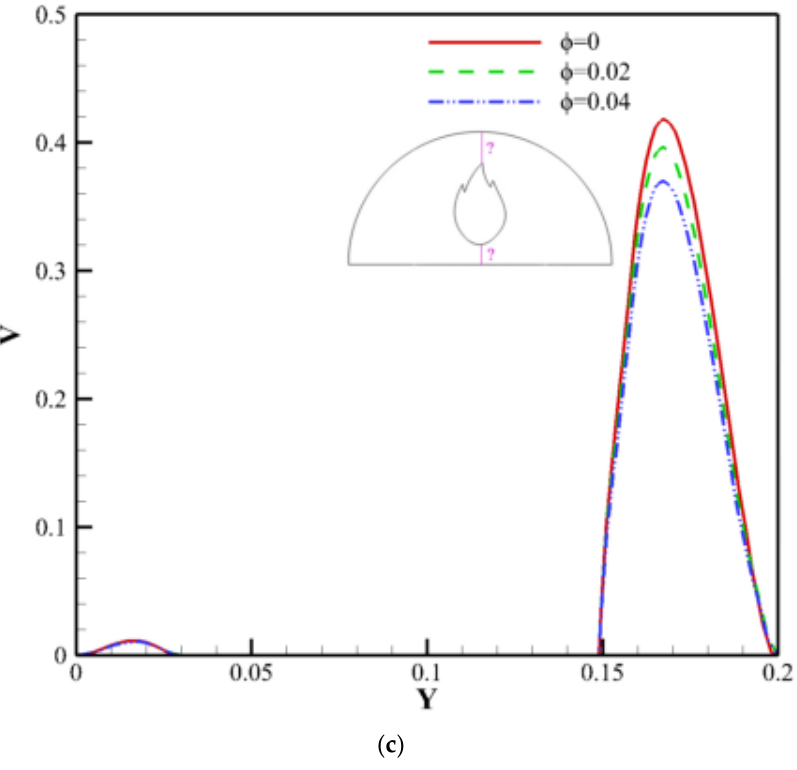
Figure 10. Variation of ( a ) Nusselt number at the enclosure heated length, ( b ) temperature along vertically mean position and ( c ) velocity alongside mean vertical location for different values of φ at (Rd = 0.5, Ha = 50, L = 0.2, Da = 10 − 4 and Ra = 10 5 ).